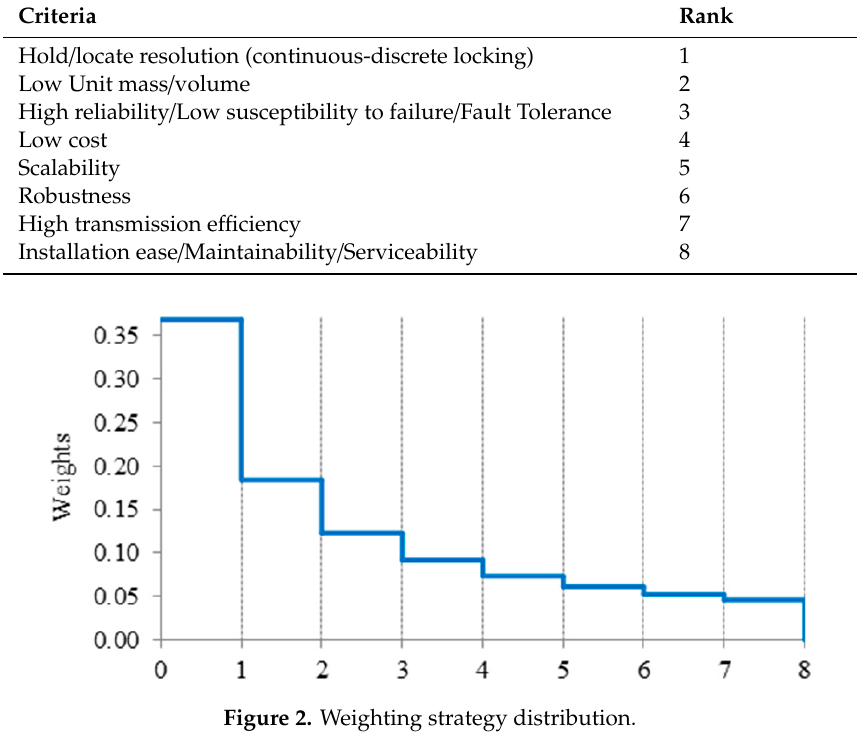
Figure 2. Weighting strategy distribution.